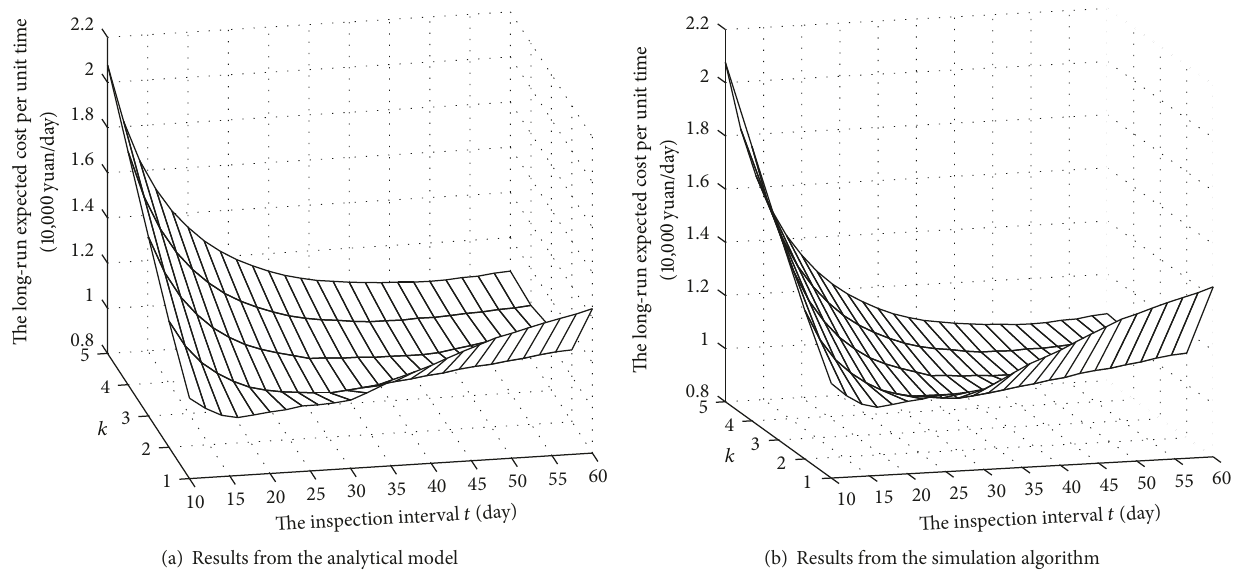
(a) Results from the analytical model (b) Results from the simulation algorithm Figure 14: Long-run expected cost per unit time of policy I obtained from model I (16) and the simulation algorithm (Figure 13).